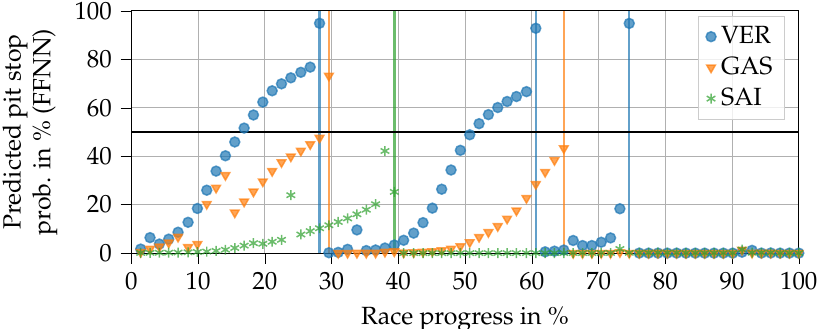
Figure 6. Progressions of pit stop probabilities for three drivers predicted by a feed-forward NN (FFNN) using real input data from the 2019 Brazilian Grand Prix. The vertical lines indicate that a real pit stop was made by the respective driver. The horizontal line at 50% probability separates the no pit stop from the pit stop region. The race was excluded from the training data. Driver abbreviations: VER—Verstappen, GAS—Gasly,